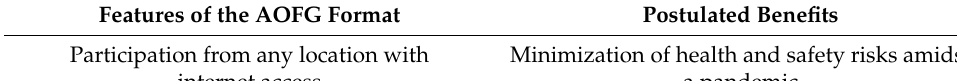
Table 1. Features of the AOFG format and corresponding postulated benefits. Features of the AOFG Format Postulated Benefits Participation from any location with internet